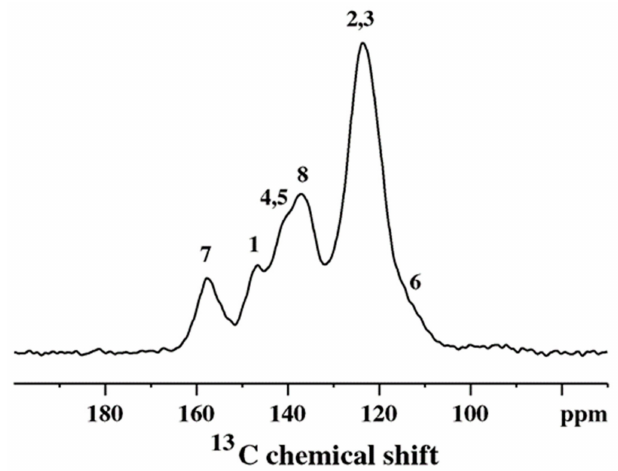
Figure 1. A typical 13 C cross-polarization magic angle spinning (CP / MAS) spectrum of chemically synthesized